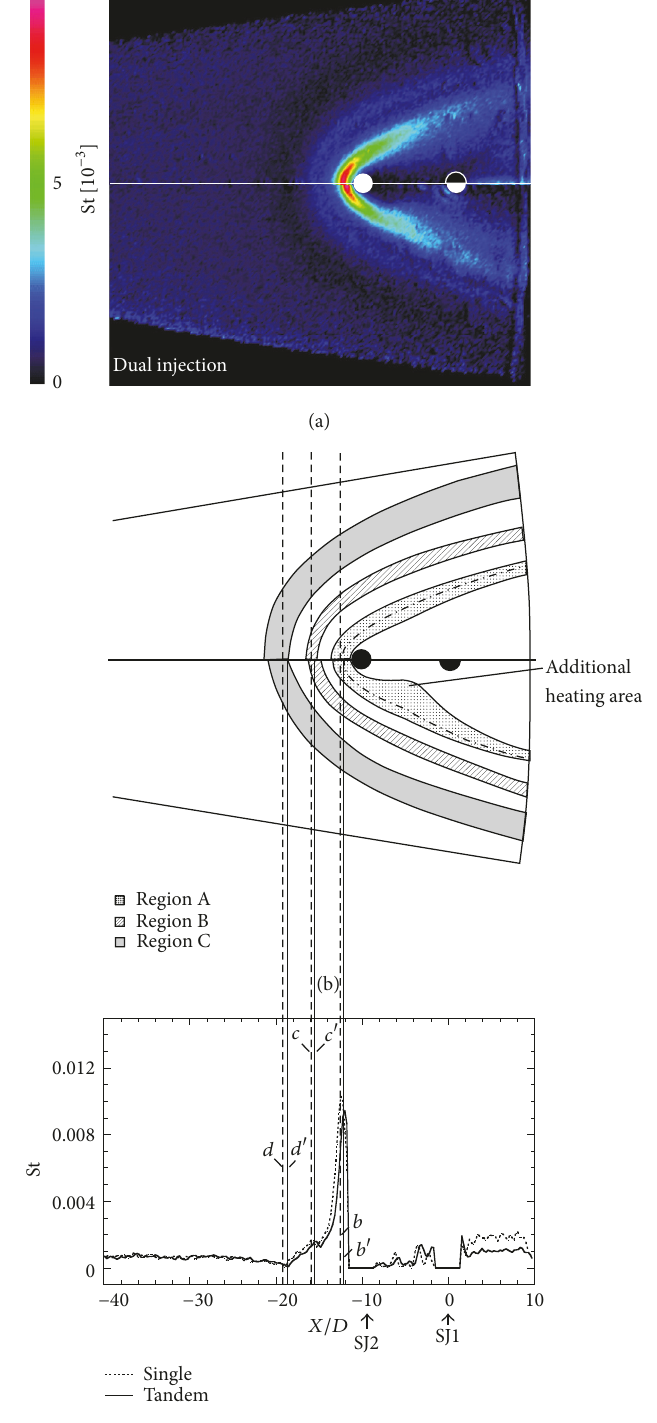
Figure 14: St distribution in tandem configuration for 𝑆 𝑥 /𝐷 = 10.1 . (a) Surface distribution of Stanton number measured by TSP, (b) a schematic of the heating patterns, and (c) one-dimensional profile of Stanton number on 𝑥 -axis, with single and tandem dual injection at 𝑆 = 10.1𝐷 . Point b , locus with peak Stanton number; point c , peak by separation vortex; point d , separation point. Prime indicates the points 𝑥 with dual injections. The upper part of (a) and (b) displays a single injection case and the lower half a dual injection